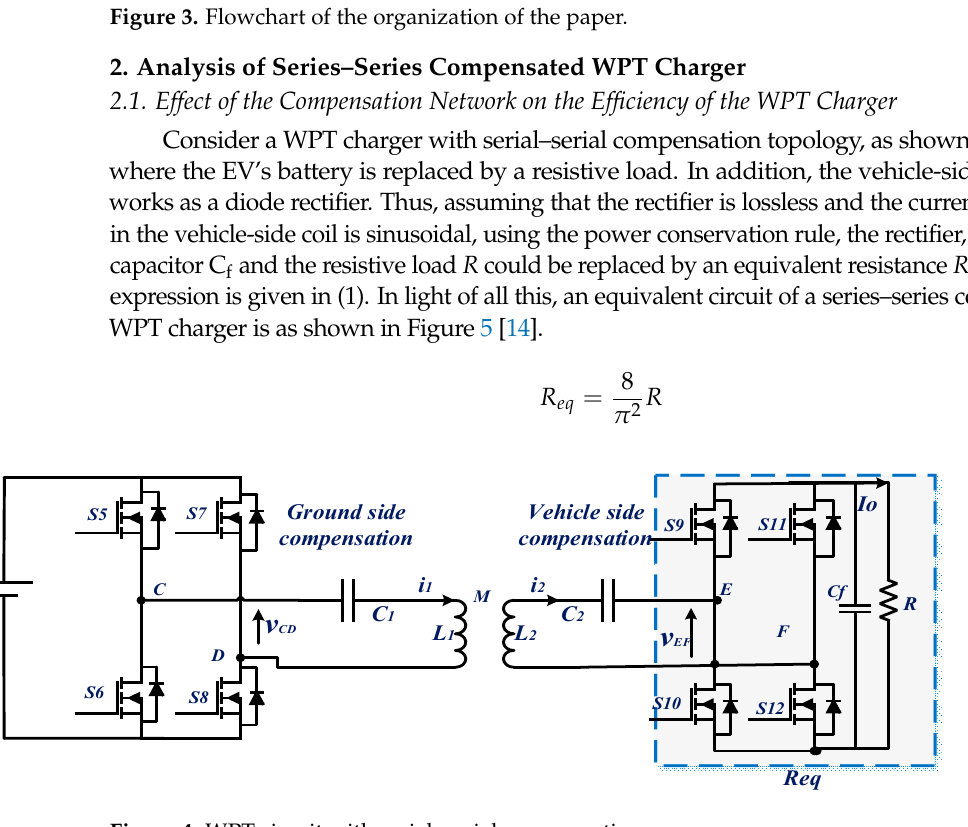
Figure 4. WPT circuit with serial–serial compensation.